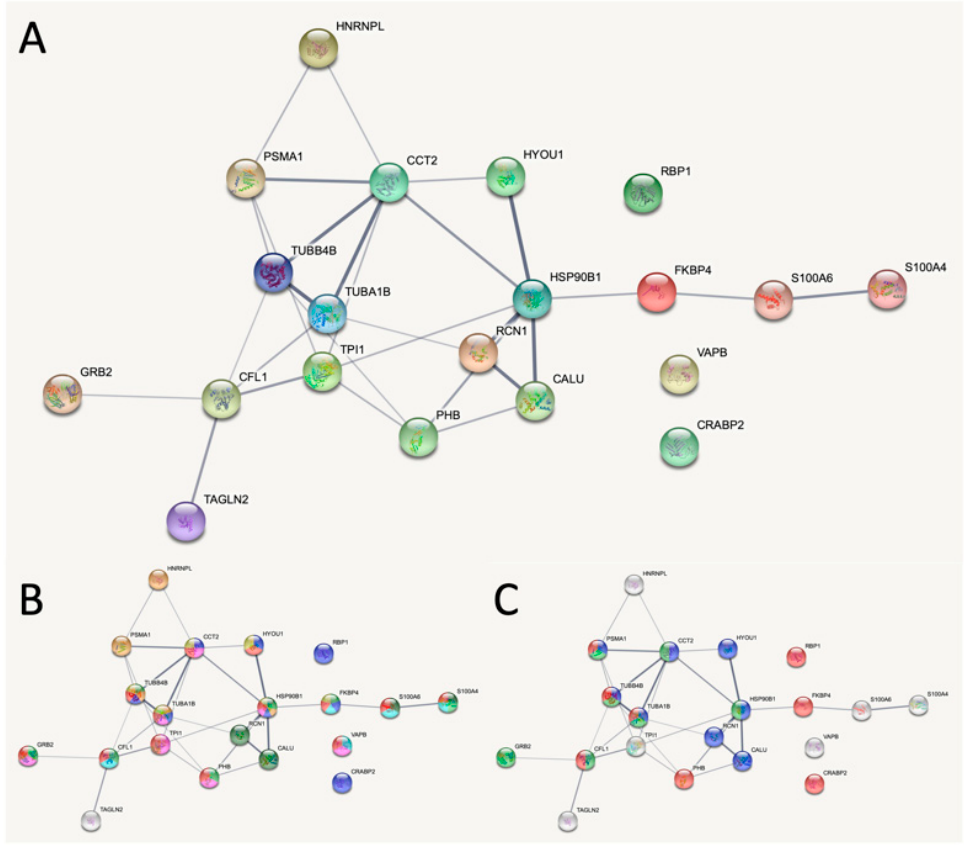
Figure 5. Bioinformatic analysis of di ff erentially expressed proteins. ( A ) STRING v11.0 was used to analyze the genes listed in Table 2 identified with two peptides together with S100A6, calumenin, and reticulocalbin: TAGLN2 (TAGL2_HUMAN), S100A4 (S10A4_HUMAN), CALU (CALU_HUMAN), RCN1 (RCN1_HUMAN), RBP1 (RET1_HUMAN), TPI1 (TPIS_HUMAN), CFL1 (COF1_HUMAN), CRABP2 (RABP2_HUMAN), VAPB (VAPB_HUMAN), HSP90B1 (ENPL_HUMAN), PHB (PHB_HUMAN), PSMA1 (PSA1_HUMAN), CCT2 (TCPB_HUMAN), TUBA1B (TBA1B_HUMAN), GRB2 (GRB2_HUMAN), TUBB4B (TBB4B_HUMAN—updated from TBB2C_HUMAN), HNRNPL (HNRPL_HUMAN), FKBP4 (FKBP4_HUMAN), HYOU1 (HYOU1_HUMAN), S100A4 (S10A4_HUMAN). The 20 proteins have 29 interactions which are significantly more than the expected 6 ( p < 1.84 × 10 − 11 ). The analysis indicated that the proteins are at least partially biologically related. ( B ) The 19 proteins involved in various binding functions are indicated with color. Red (13 proteins): ‘protein binding’; blue (8 proteins): ‘small molecule binding’; light green (7 proteins): ‘signaling receptor binding’; pink (7 proteins): ‘enzyme binding’; yellow (6 proteins): ‘purine ribonucleotide binding’; green (5 proteins): ‘calcium ion binding’; brown (5 proteins): ‘RNA binding’; light blue (5 proteins): ‘cytoskeletal protein binding’. ( C ) Proteins identified to be part of Reactome pathways. Red (8 proteins): ‘signal transduction’; blue (8 proteins): ‘metabolism of proteins’; green (7 proteins): ‘immune system’.